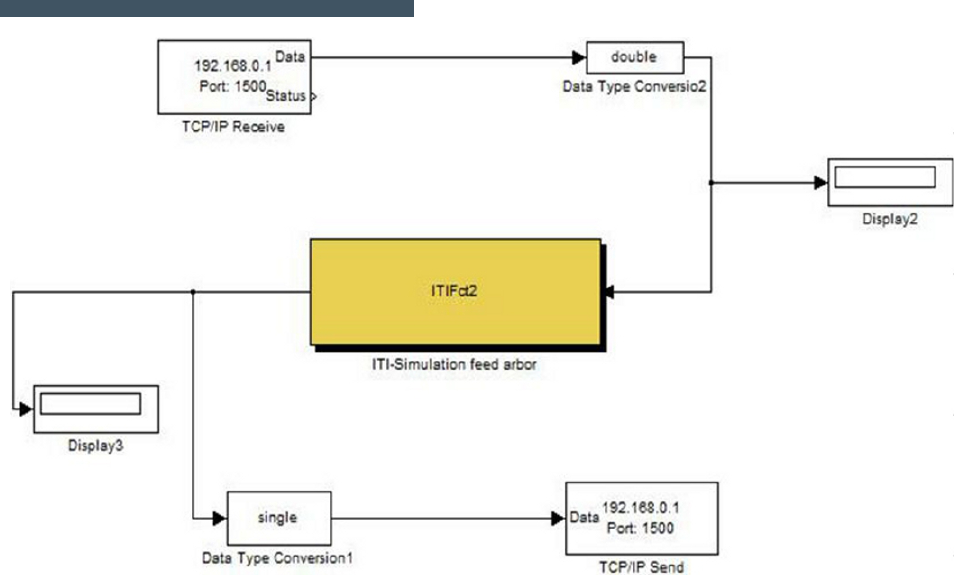
Figure 4. Co-simulation between STEP7 and SimulationX through Matlab Simulink .